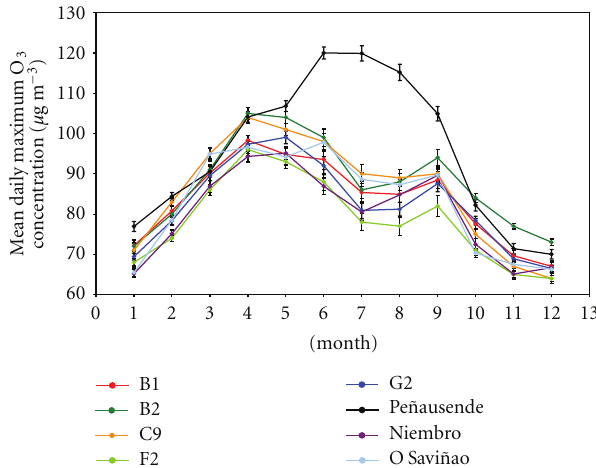
Figure 10: Series of monthly mean of daily maximum ozone concentrations throughout the 5-year-study period (2002–2006) for each site.